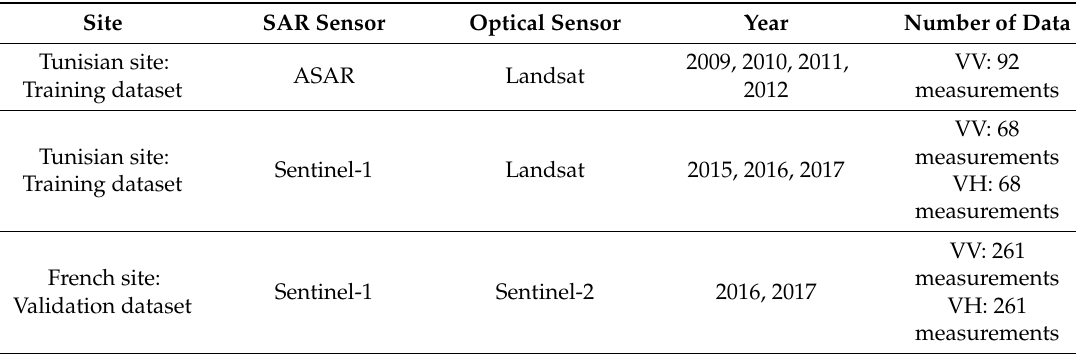
Table 1. Description of the dataset used in this